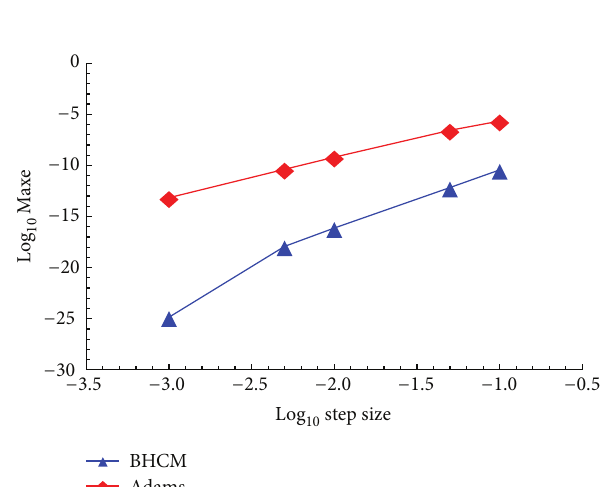
Figure 2: Performance comparison for Problem 2 when 𝑏 = 40 .